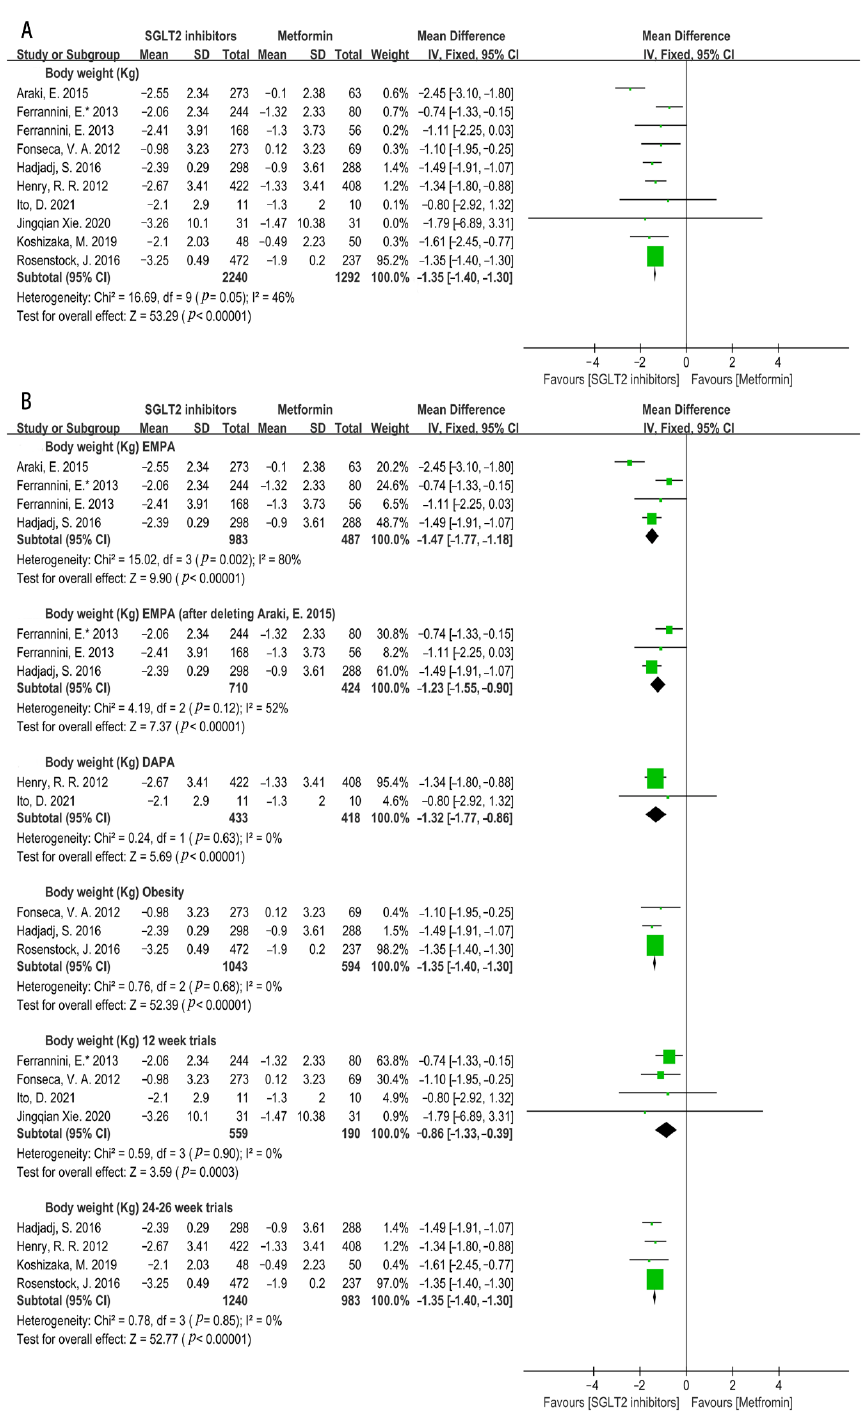
Figure 12. ( A ). Weighted mean difference in change in body weight (Kg) from baseline from SGLT2i compared with metformin [20–24,26,29–32]. ( B ). Weighted mean difference in change in body weight (Kg) from baseline from types of SGLT2i compared with metformin. Weighted mean difference in change in body weight (Kg) from baseline from SGLT2i used 12 weeks or 24–26 weeks compared with metformin and weighted mean difference in change in body weight (Kg) from baseline from SGLT2i in obesity patients [20–24,26,29–32]. DAPA = dapagliflozin, EMPA = empagliflozin. 12 weeks trials = SGLT2i used 12 weeks, 24–26 weeks trials = SGLT2i used 24–26 weeks. Obesity = SGLT2i used in obese